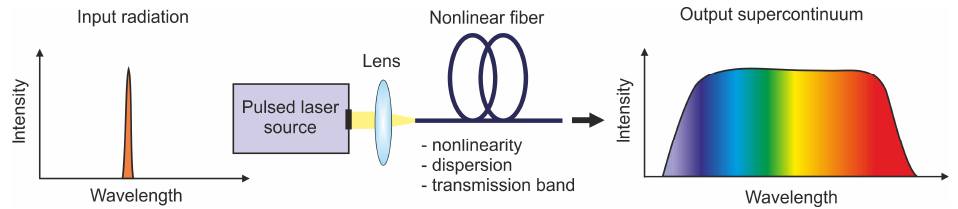
Figure 1. Schematic setup for SC generation.